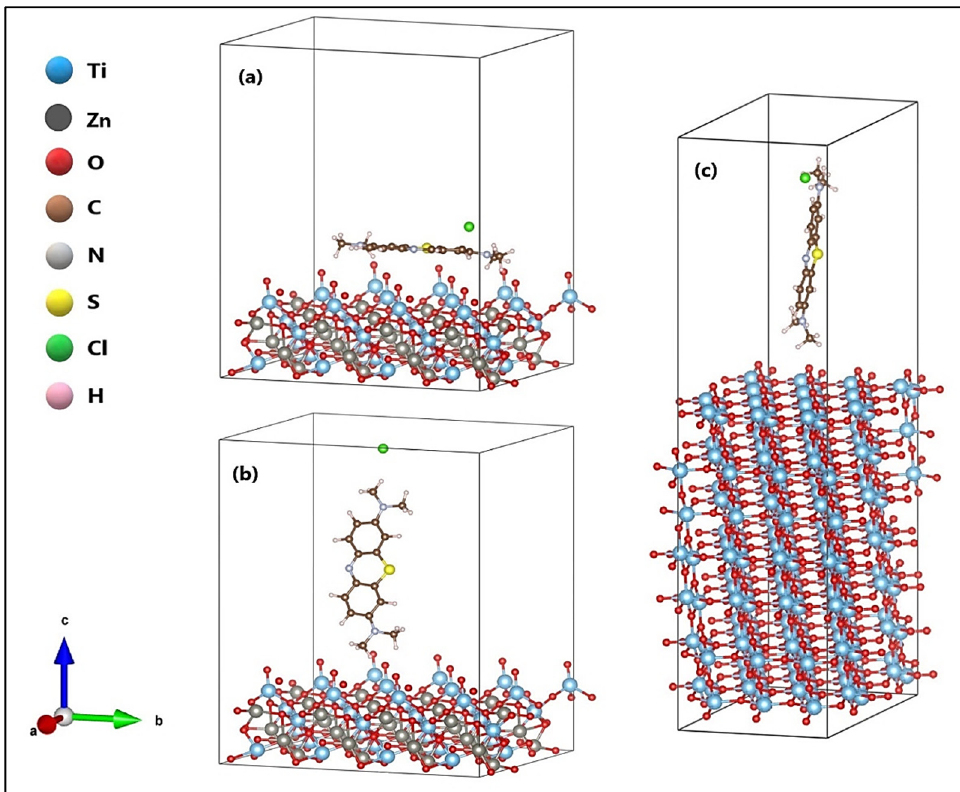
Figure 5. Methylene blue (MB) molecule in ( a ) horizontal and ( b ) semi-perpendicular orientation on the ZnTiO 3 surface, and ( c ) semi-perpendicular orientation on the TiO 2 surfaces. The anchoring modes of the MB molecule on the ZnTiO 3 and TiO 2 surfaces are shown in Figure 6. Adsorption of the dye on the ZnTiO 3 and TiO 2 surfaces occurs in a bidentate chelating (BC) adsorption model [57] with two protons oriented toward the nearest sur- face oxygen [58].